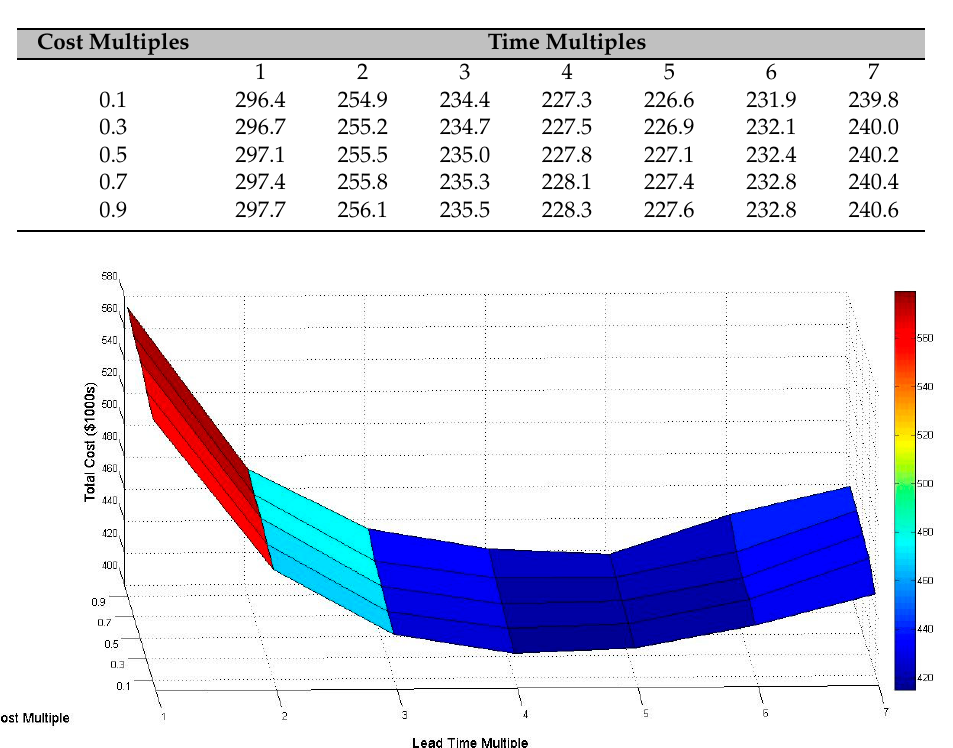
Table 8. Total integrated costs for the medium test instance set in $1000s.